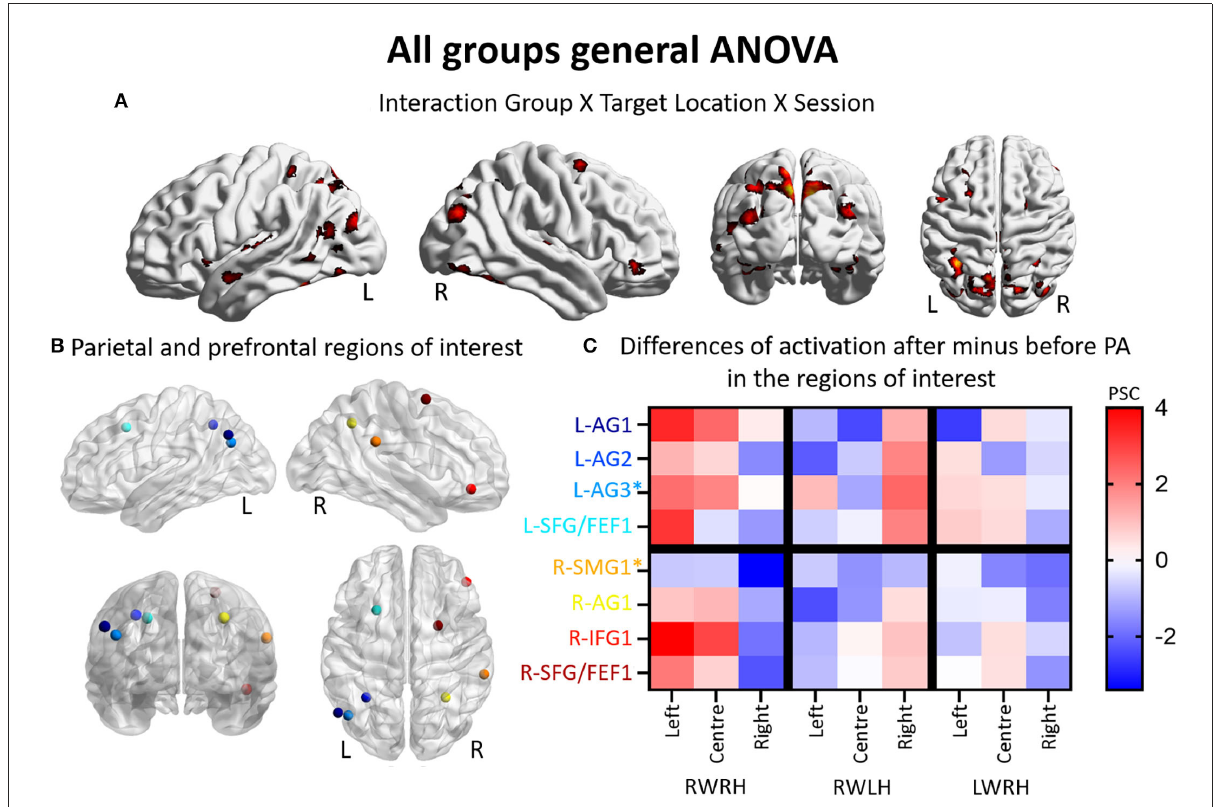
FIGURE1 Modulation of brain activation as revealed by the general ANOVA including the three experimental groups (RWRH, RWLH, LWRH). (A) Surface renderings of significant brain activation in the interaction between the factors Group (RWRH, RWLH, LWRH) x Target location (left, center, right) x Session (pre, post), from left to right: lateral views of the left and right hemisphere, view from the back and the top. All maps are thresholded at p < 0.05, cluster extent k > 64. (B) Spheres located on the peaks of activation clusters in the parietal and prefrontal regions. Lateral views of the left and right hemispheres, above the back and top views. Color code denotes names of the regions, as indicated on the y -axis in C. (C) Differences of activation in percent signal change, after minus before PA, for each group (RWRH, RWLH, and LWRH) and each target position (left, center, and right). Asterisks mark two additional regions, which were identified in a previous study by contrasting the effect of R-PA to that of plain glasses (Crottaz-Herbette et al., 2014). Activation thresholded at p = 0,05 and k = 64 (expected numbers of voxels per clusters provided by SPM12) 0.4 AG, angular gyrus; FEF, frontal eye field; IFG, inferior frontal gyrus; L, left; PSC, percent signal change; R, right hemisphere; SFG, superior frontal gyrus; SMG, supramarginal